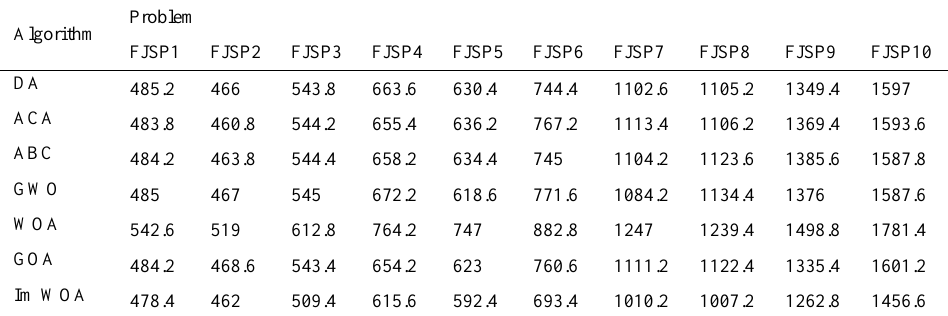
Table 1. The average results of ten counts of